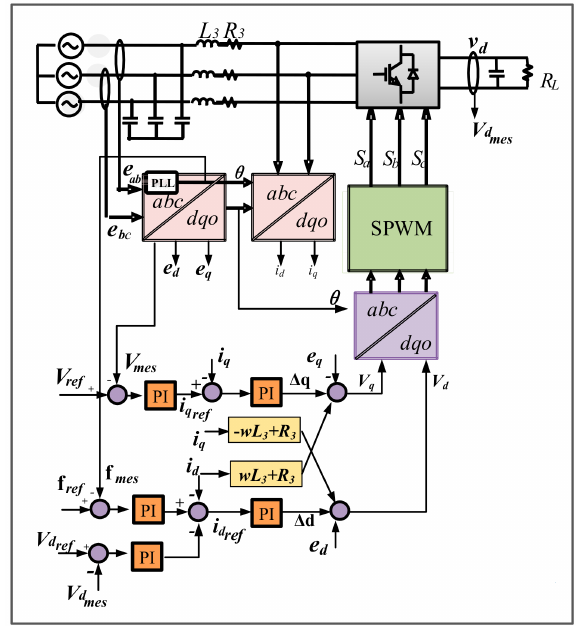
Figure 7. Schematic diagram of the bidirectional DC-AC